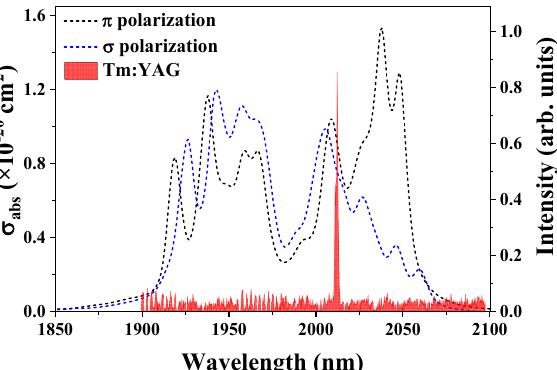
Figure 4. Output spectrum of the Tm:YAG laser and the absorption of the Ho:GdVO 4 crystal. Figure 5 shows the experimentally measured power characteristics of the intra-cavity Ho:GdVO 4 laser as a function of the incident pump light. The laser obtained a maximum output power of 1.6 W when the pump power was 9.2 W and the center wavelength was 1617 nm. After fitting, the slope efficiency of the intra-cavity Ho:GdVO 4 laser was 28.0%. In addition, the power stability of the intra-cavity Ho:GdVO 4 laser was estimated. At a fixed incident pump power of 9.2 W, the output powers were recorded during 1 h, resulting in a power stability of 2.3%.